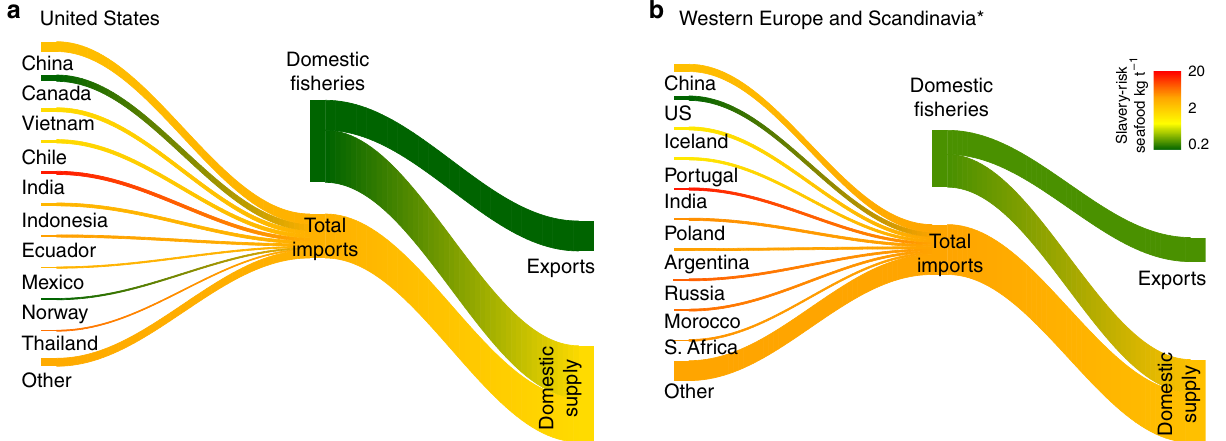
Fig. 3 River plots showing the impact of seafood imports on the modern slavery risk of domestically consumed seafood. Slavery risk is expressed in kilograms of seafood from slavery-risk countries per tonne consumed. Slavery risk scores based on the Global Slavery Index; trade fl ows from CEPII ’ s BACI database of harmonised UN COMTRADE data. Plots show seafood imports for a the United States and b Western Europe and Scandinavia (includes Denmark, France, Germany, Ireland, Netherlands, Norway, Spain, Sweden, and United Kingdom). Colour of trade fl ow components indicates the intensity